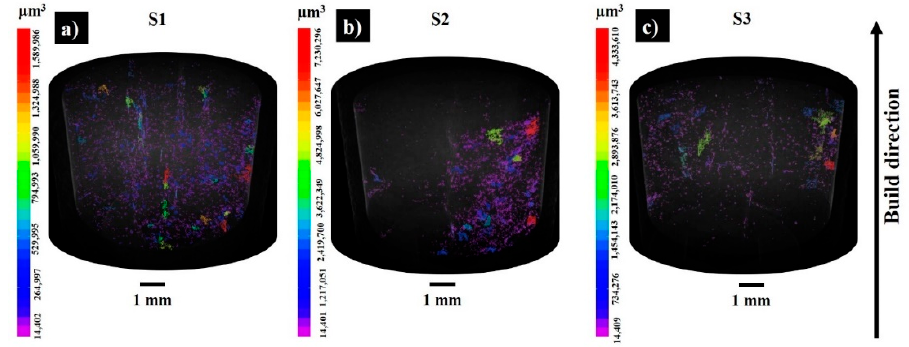
Figure 3. The 3D visualization of the porosity results in as-built samples S1 ( a ), S2 ( b ), and S3( c ) (pores are labelled by volume (µm 3 )).